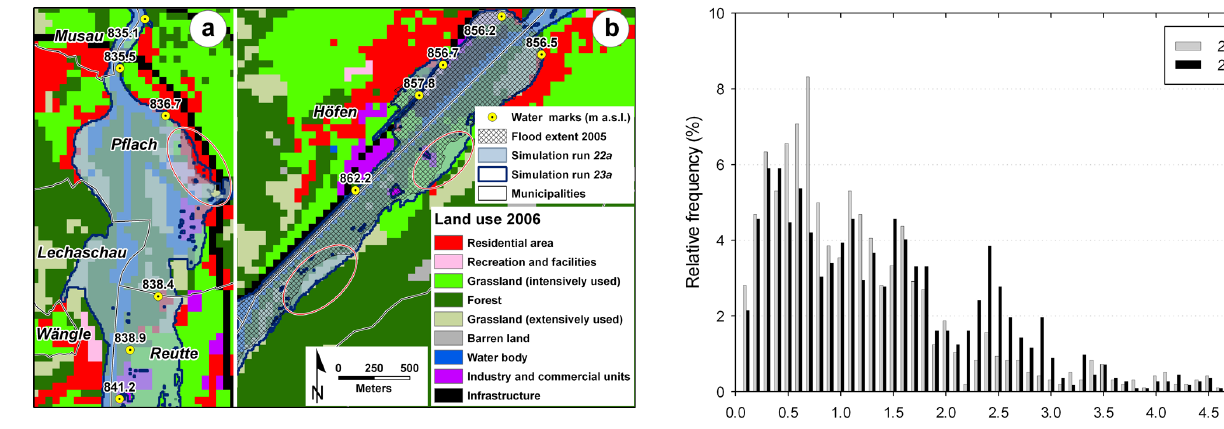
Fig. 2. Comparison of the recorded water marks and the mapped flood extent of the flood event in 2005 with the two hydraulic- simulation runs “22a” (dike heights as in 2005) and “23a” (dike heights as in 2005 but considering dike breaches) in the northern (a) and in the southern part (b) of the study area. The red circle in figure (a) illustrates the location of the difference in the flood ex- tents at the community of Pflach between both runs. The red circles in figure (b) display the differences between the observed and mod- eled flood extents in the southern study area.